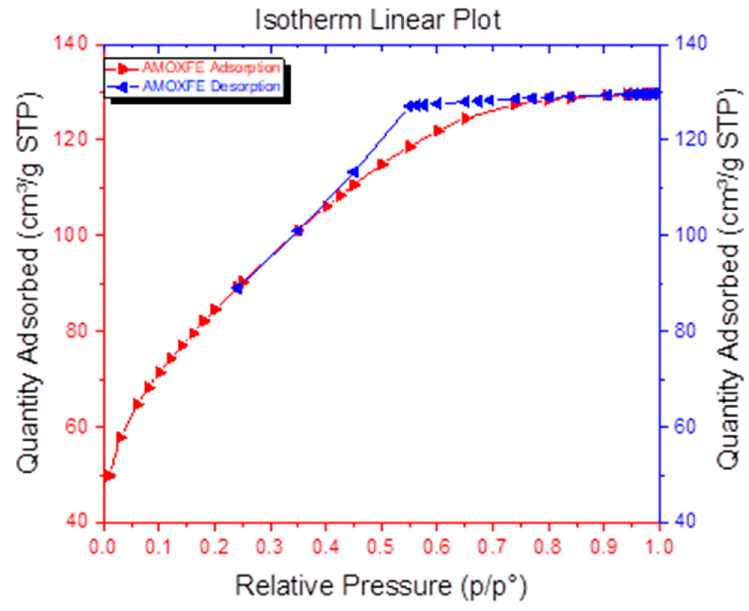
Figure 13. Specific surface area of the manometric